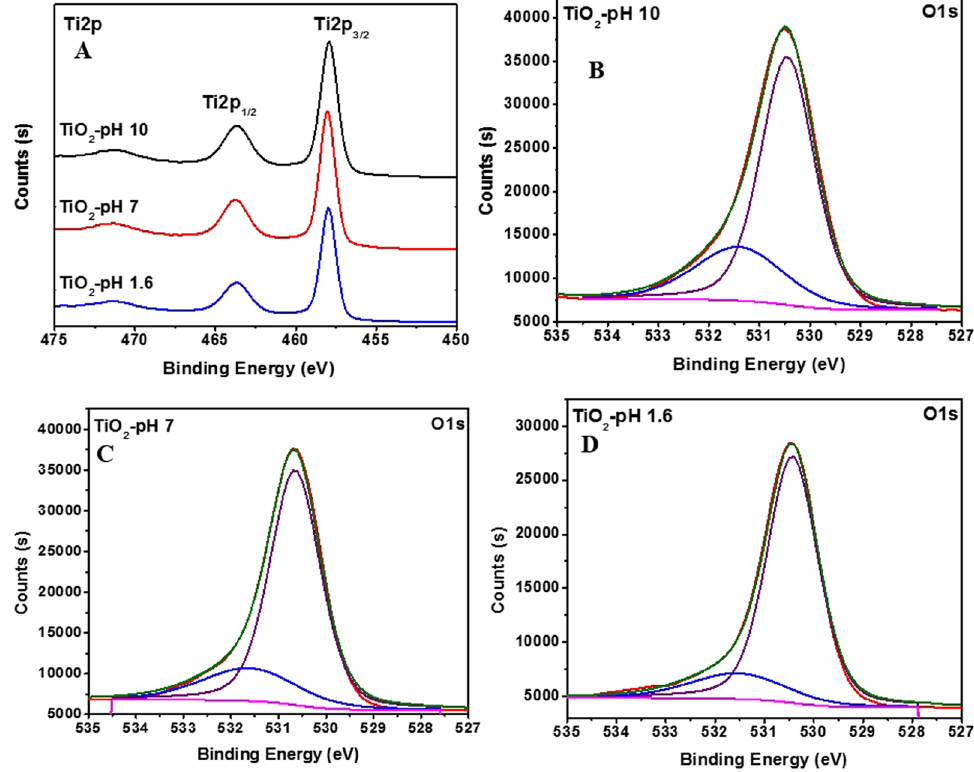
Figure 4. Deconvoluted XPS peaks for: ( A ) Ti 2 P, ( B ) O1s for pH 10, ( C ) O1s for pH 7.0 and ( D ) O1s for pH 1.6.